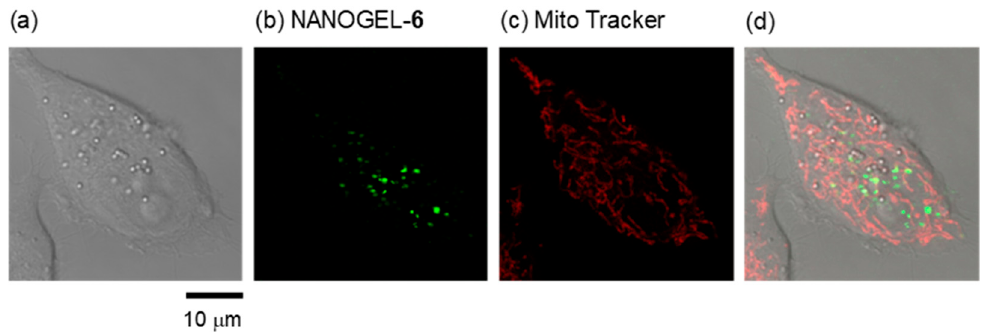
Figure 5. Cationic fluorescent nanogel thermometer NANOGEL- 6 in a live HeLa cell. ( a ) Transmitted light image; ( b ) confocal fluorescence image of NANOGEL- 6 (excitation: 458 nm; emission: 500–600 nm); ( c ) confocal fluorescence image of mitochondria visualized with Mito Tracker DR (excitation: 633 nm; emission: 645–730 nm); ( d ) merged image.